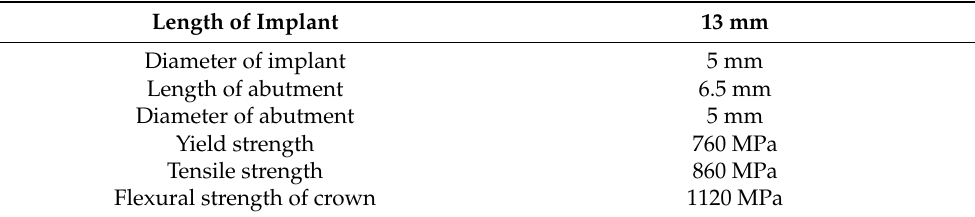
Table 1. Physical and mechanical properties of implant, abutment, and crown. Length of Implant